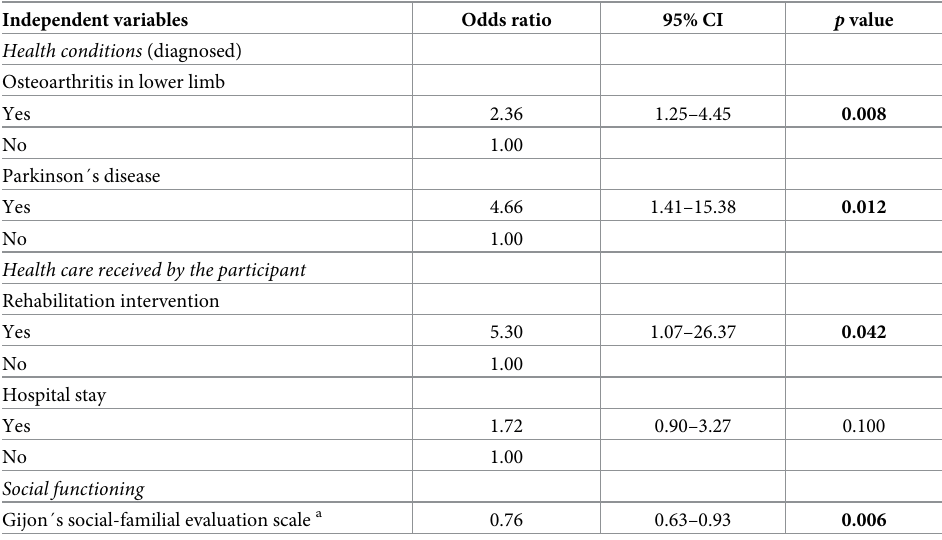
Table 5. Multivariate logistic regression predicting the implementation of a bathroom adaptation ( n =